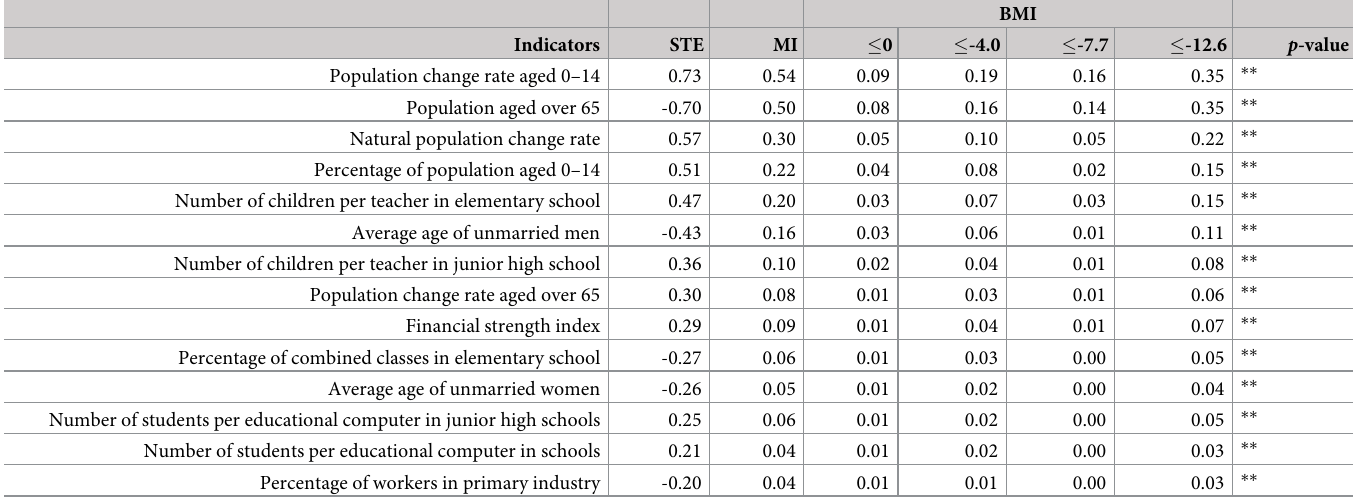
Table 1. STE, MI, BMI, and p-value of each indicator.